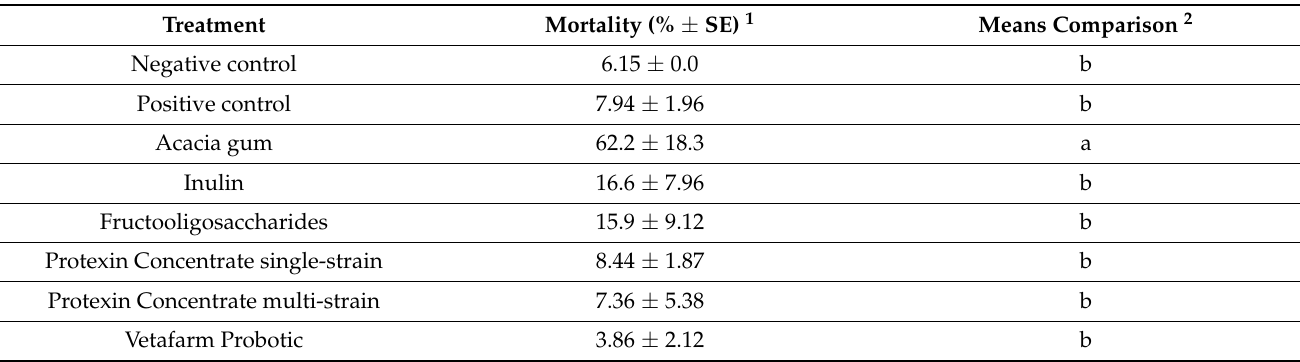
Table 3. Mean bee mortality ± SE (%) of non-infected (negative control) and N. ceranae -infected bees fed sugar syrup (positive control) or sugar syrup containing prebiotics or probiotics.